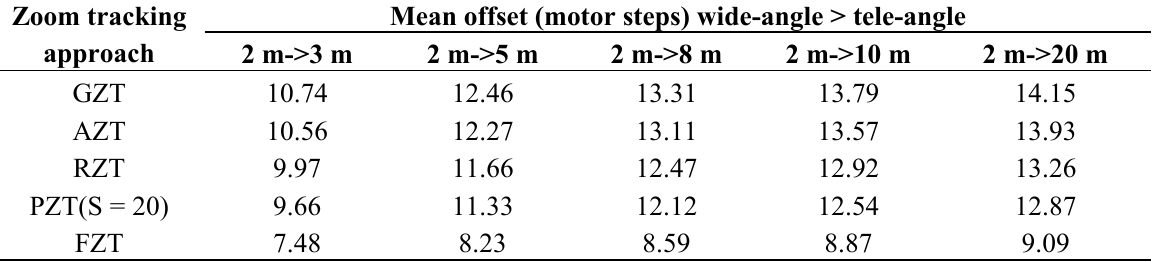
Table 3. Tracking accuracy for moving